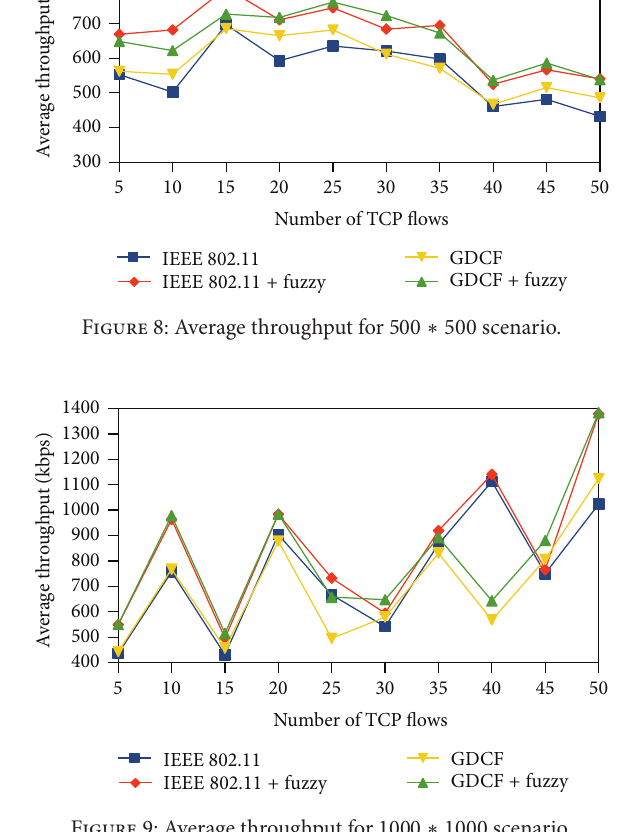
transmitted. It is plotted in 𝑦 -axis. Packet delivery ratio reflects the percentage of successful transmission. PDR of fuzzy based approaches is high than IEEE 802.11 and GDCF. It is diagrammatically shown in Figures 13, 14, and 15.